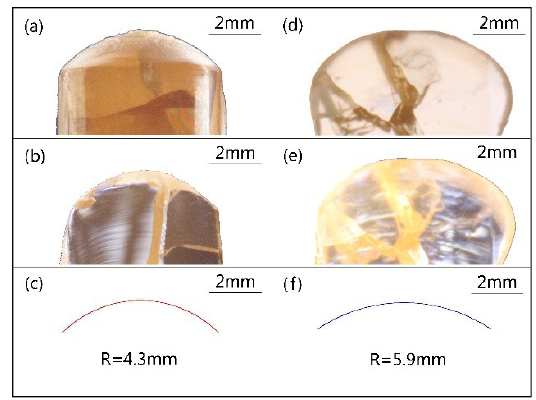
Figure 4. The dependency of curvature of Y 2 Ti 2 O 7 crystal striations from overheating (nominal input power). Sample #1 (2.55 kW, low overheating): left column. ( a ) Picture of the tip of the as-grown crystal, ( b ) polarized picture of the tip of the central slice, ( c ) an arc matched the striation. Sample #5 (2.75 kW, high overheating): right column. ( d ) Picture of the tip of the central slice, ( e ) polarized picture of the tip of the central slice, ( f ) an arc matched the striation.